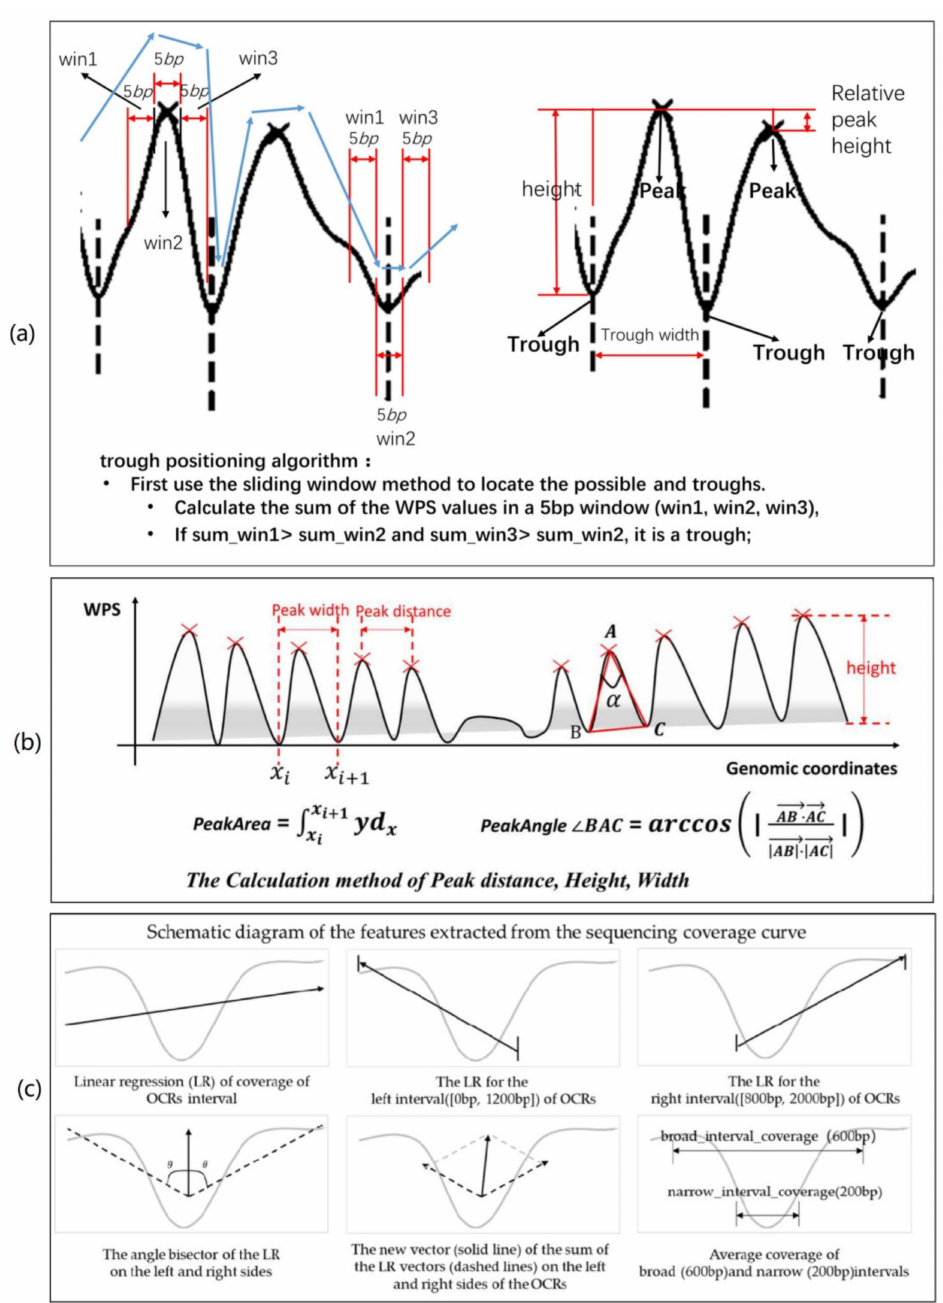
Figure 10. ( a ) The schematic diagram of the trough positioning algorithm. ( b ) The region where the peaks disappear in the middle of the picture is the possible open chromatin region. ( a , b ) show the calculation methods of each indicator, respectively. ( c ) The features extracted from the sequencing coverage curve of the initial